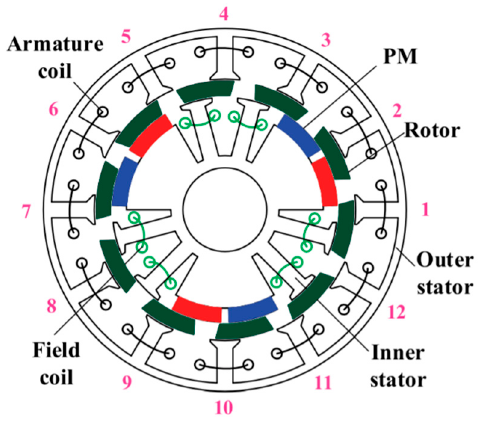
Figure 20. Configuration of a parallel hybrid PS-FMPM machine [50].